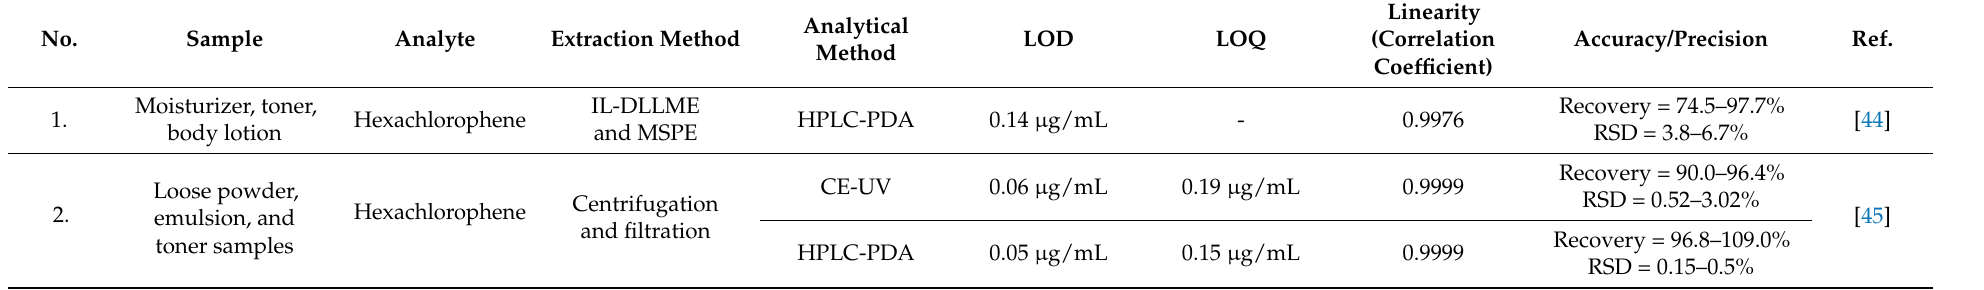
Table 7. Analytical method for determining hexachlorophene in